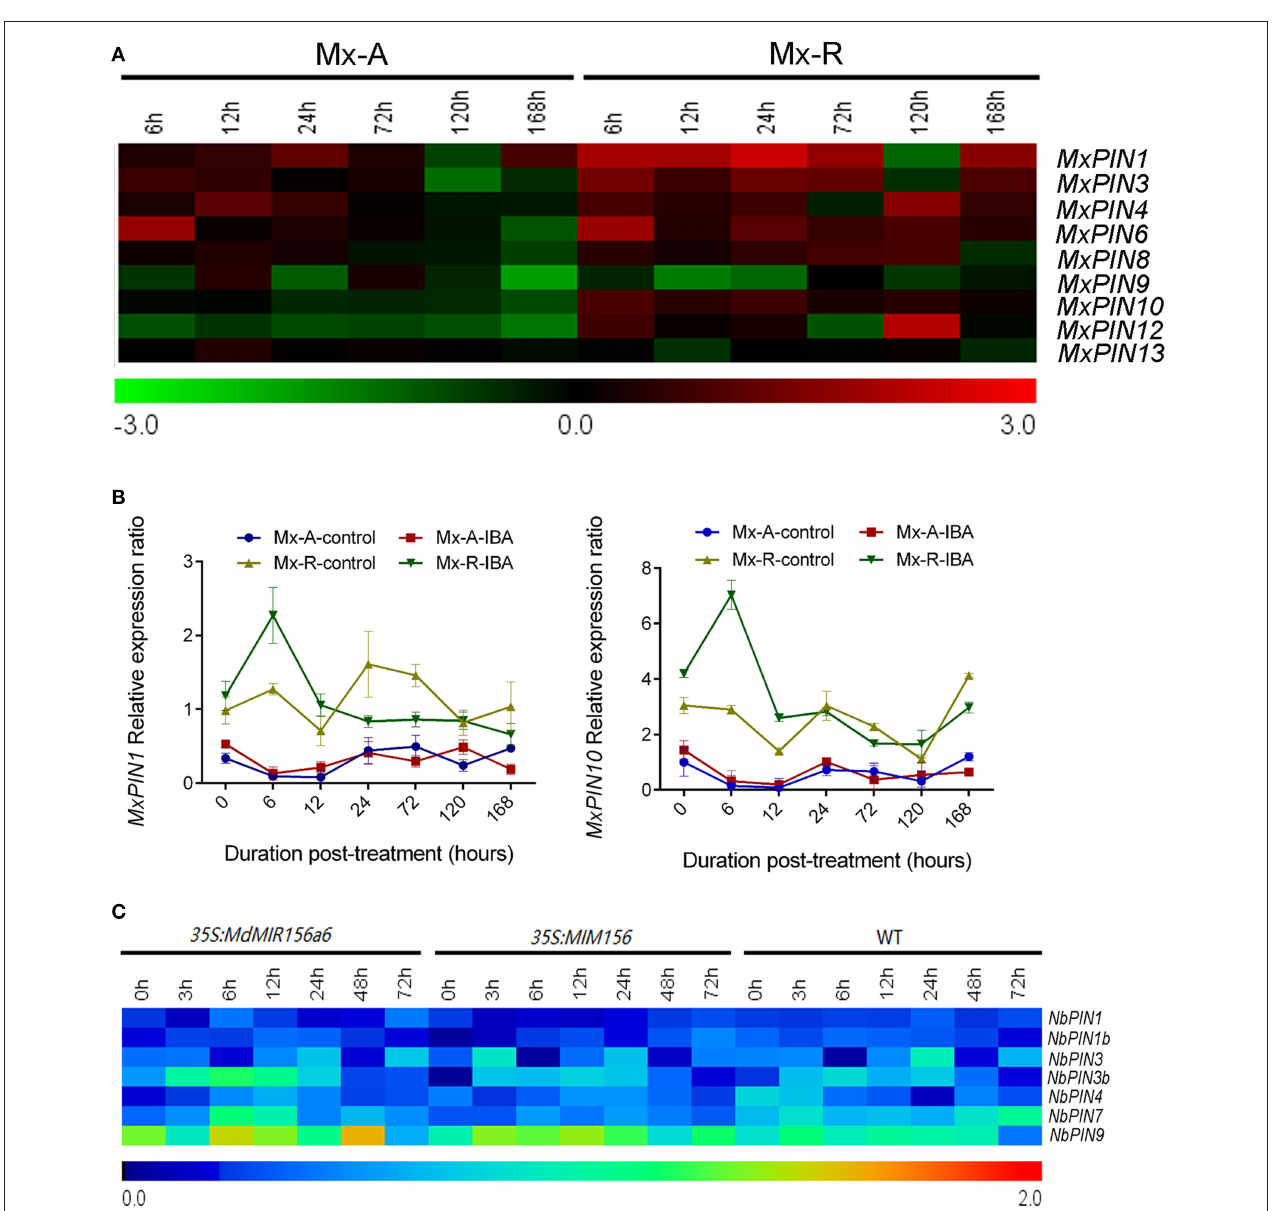
FIGURE 7 | Expression profiles of PINs during adventitious rooting in Malus xiaojinensis and transgenic Nicotiana benthamiana . All the results of semi-quantitative RT-PCR were quantified using the ImageJ software. Log-transformed values of the relative expression levels of MxPIN family genes under IBA treatment compared to controls were used for hierarchical cluster analysis with MeV 4.8.1. The color scale represents relative expression levels with red denoting up-regulation and green denoting down-regulation. The relative expression levels of NbPIN genes compared to NbEF1 α were used for hierarchical cluster analysis with MeV 4.8.1. Sampling times are indicated at top of the figure. (A) Expression profiles of MxPIN genes in stem bark of Mx-A and Mx-R during adventitious root formation process after IBA treatment (original results show in Supplementary Figure 4 ). (B) Quantitative RT-PCR analysis of the expression dynamics of MxPIN1 and MxPIN10 in stem bark from Mx-A and Mx-R during adventitious root formation after IBA treatment. Bars show SD from three biological replicates. (C) NbPIN genes expression patterns in WT, 35S:MdMIR156a6, and 35S:MIM156 transgenic tobacco stems during the adventitious rooting process (original results show in Supplementary Figure 5